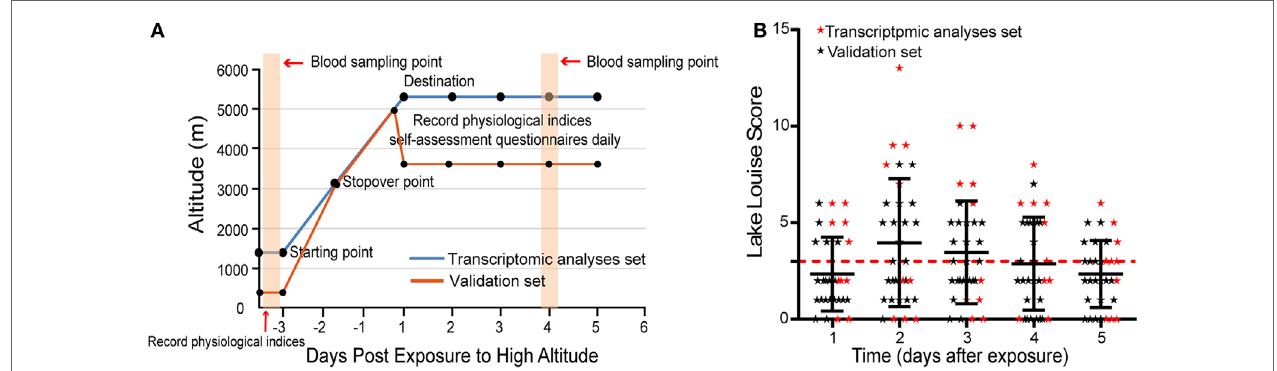
FigUre 1 | The distribution of lake louise scores and symptoms during the investigation period . (a) Schematic of study procedure. (B) Scatter plot for the LLS of all individuals. The numbers correspond to the days when acute mountain sickness (AMS) was assessed. The red dashed line denotes the threshold of diagnosis for